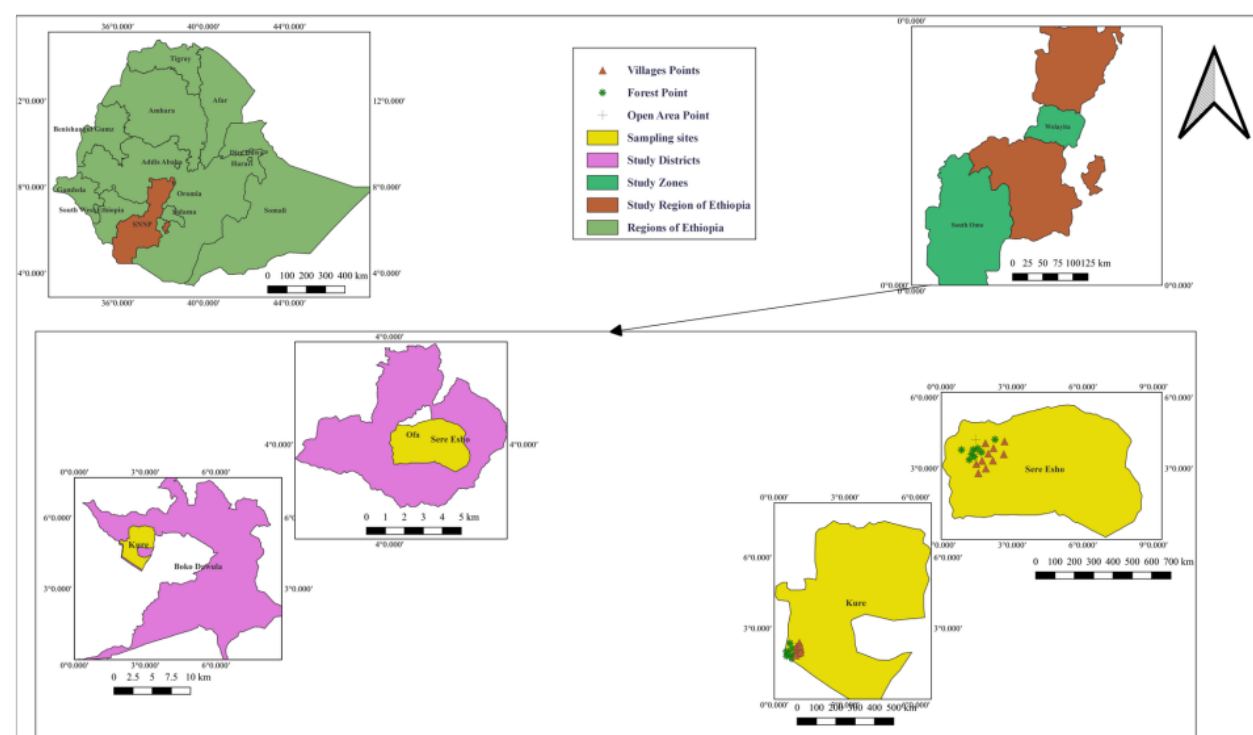
Figure 1. Map of the study sites in the Boko Dawula District in the South Omo Zone and the Ofa District in the Wolaita Zone, both in the Southern Nations, Nationalities and Peoples’ Region (SNNPR) in southwestern Ethiopia.